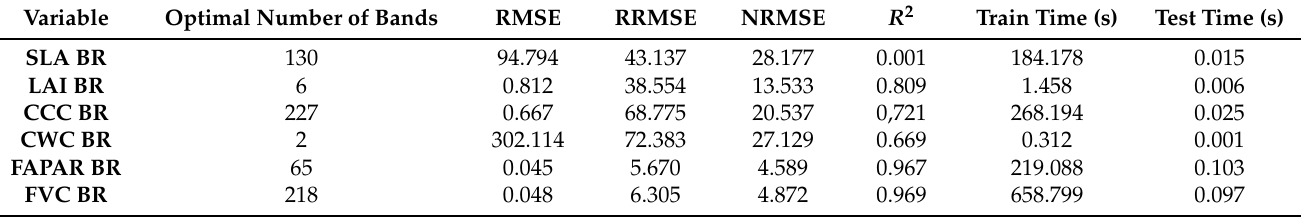
Table A1. Statistical results obtained with the optimal number of bands for each variable identified by GPR-BAT and validated against the Grosseto and MNI in situ data sets (and theoretical results for FVC and